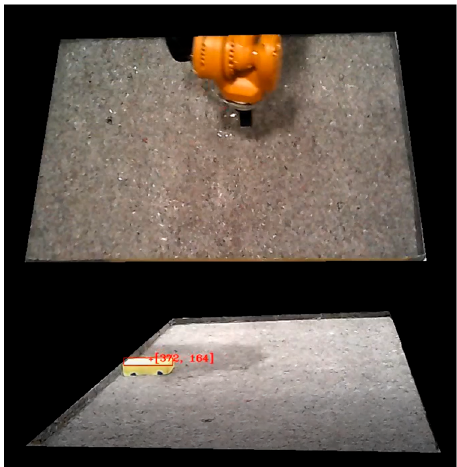
Figure 18. Frames from a particular moment during demonstration in which the robotic arm blocks the vision of Cam-1 (top) but Cam-2 (bottom) is able to keep tracking the obstacle.